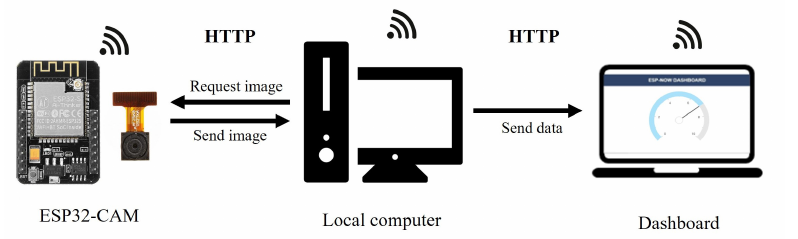
Figure 17. Architecture of the IoT implementation.